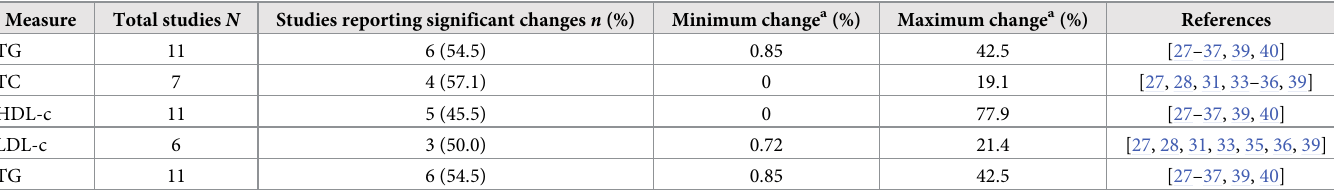
Table 4. Changes in lipid profile.